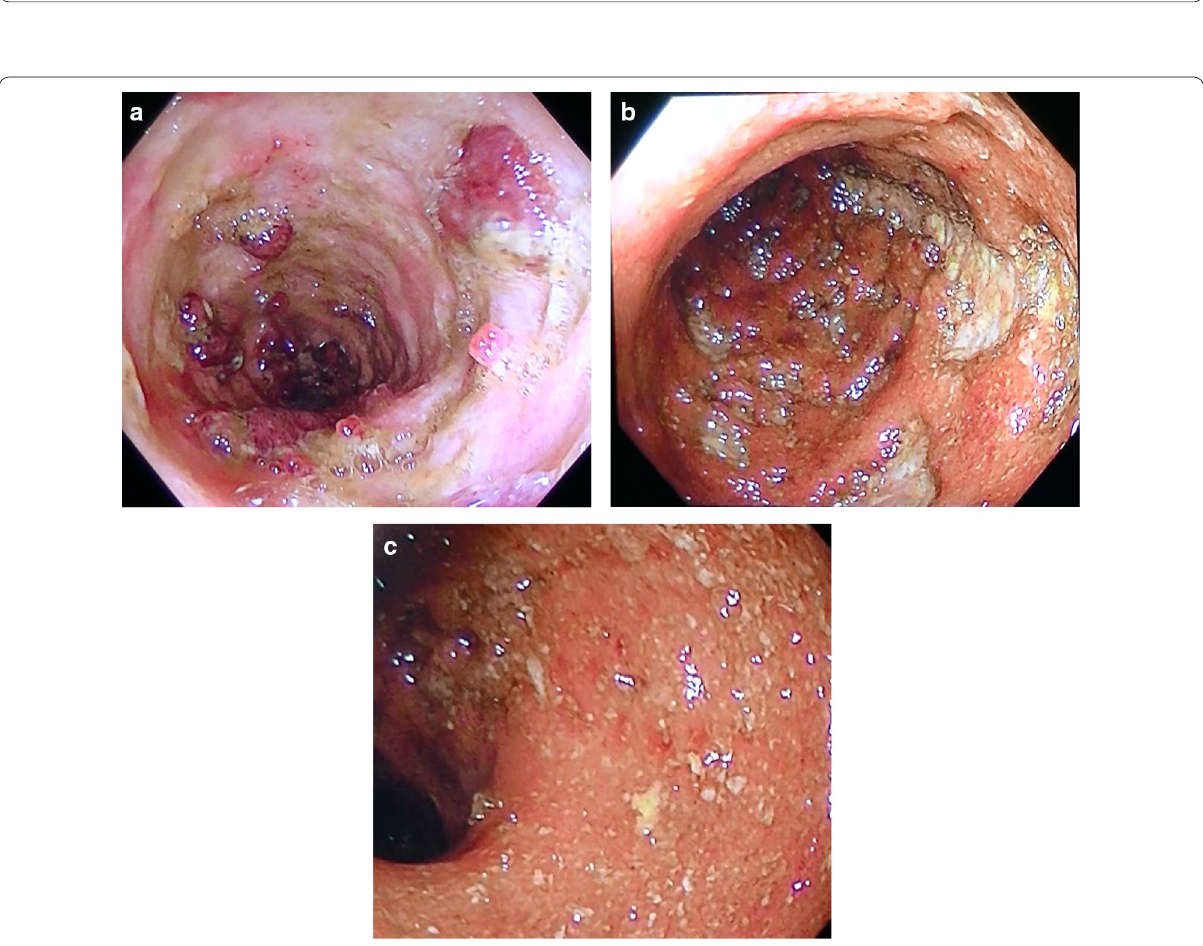
Fig. 4 Colonoscopy performed on the day of transfer. A circumferential ulcer was found in the transverse colon ( a ). A deep ulcer was found in the sigmoid colon ( b ). Edematous inflammation with no ulcer was found in the rectum ( c